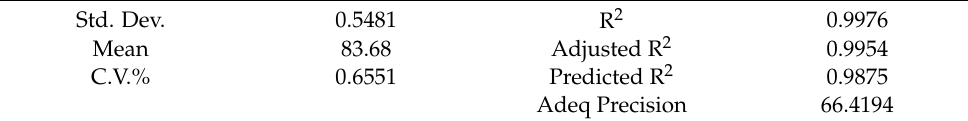
Table 4. Statistical parameters estimated from the ANOVA study for the